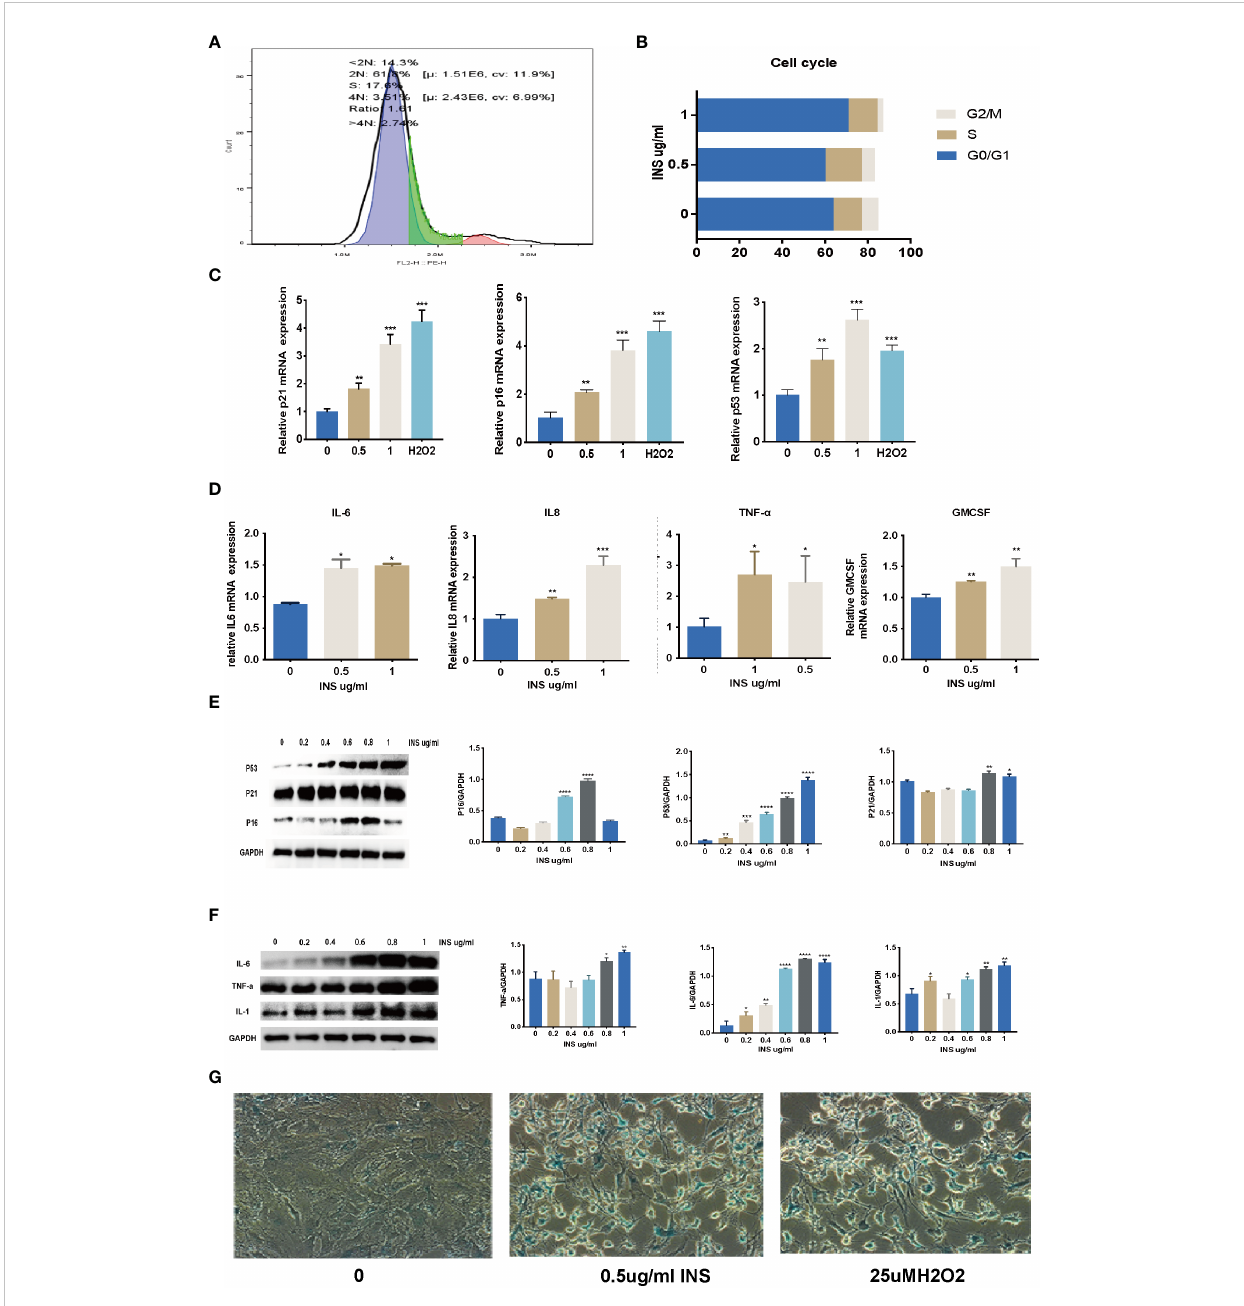
FIGURE 3 Long time exposure to high dose insulin induced granulosa cell senescence. KGN cells were treated with solvent, 0.5, and 1 µM insulin, respectively. (A, B) Cell cycles were detected by fl ow cytometry after treatment with 0.5 uM or 1 uM insulin for 72 h. (C, D) RNA was extracted from KGN cells. Relative mRNA expression of p21, p53, p16, IL6, IL8, TNF-a , and GM-CS F were examined by qPCR. n=3; t-test. (E, F) RNA was extracted from the cells. p21, p53, p16, IL1, IL6 , and TNF-a protein expression were examined by western blot analysis. n=3; t-test. n=3 with one repeat in each assay; one-way ANOVA. (G) KGN cells with strong SA- b -Gal expression were detected induced by the high dose insulin. *: P<0.05, **: P<0.01, ***: P<0.001, ****: P<0.0001 compared to group “ 0 ”